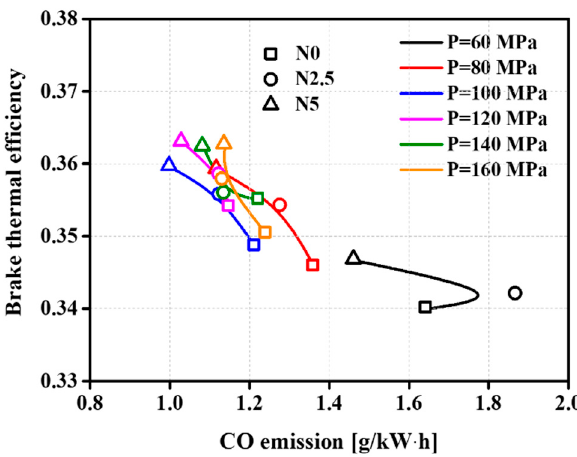
Figure 15. Brake thermal efficiency–CO relationship of n -octanol/diesel blends with different injec- tion pressures.